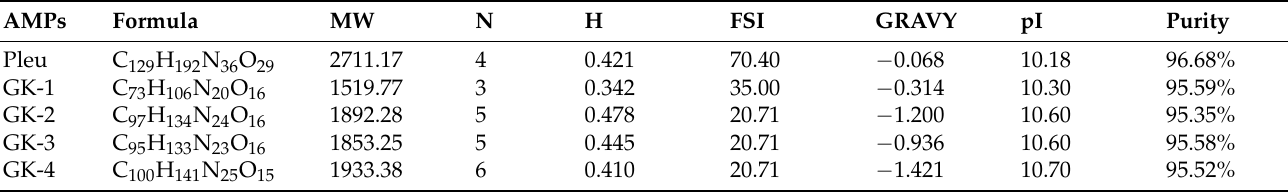
Table 1. Key physicochemical parameters of amphipathic